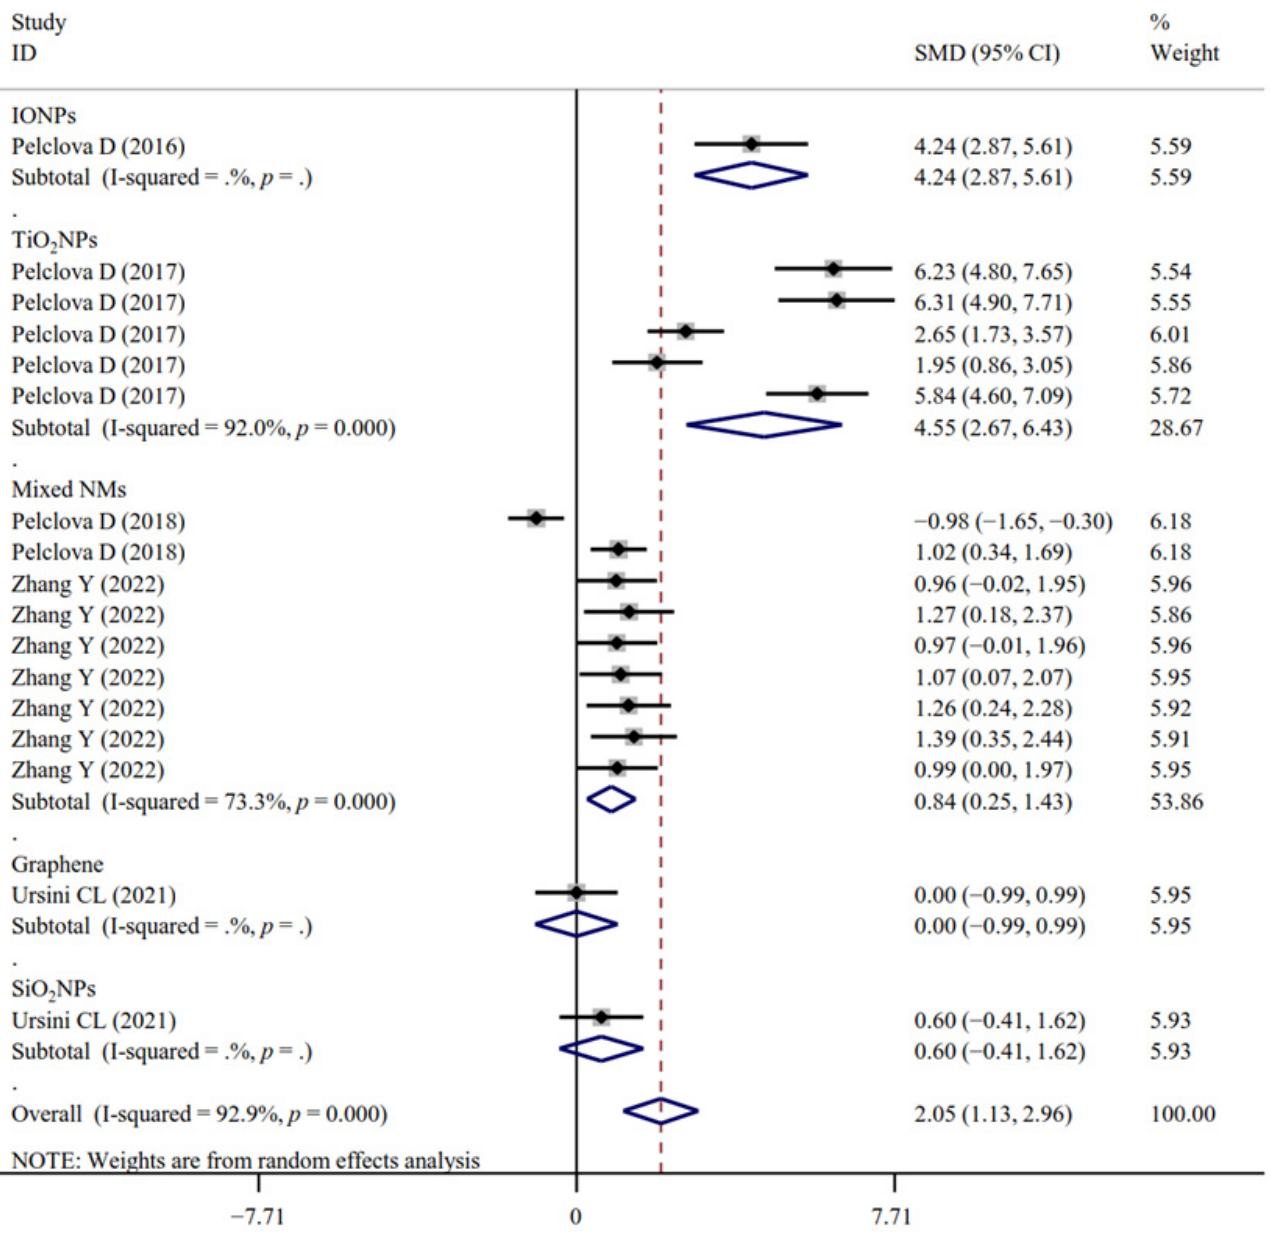
Figure 4. Forest plots assessing the effects of exposure to different NMs on the level of HNE compared with the non-exposed control group. NMs, nanomaterials; SiO 2 NPs, silica oxide nanoparticles; IONPs, iron oxide nanoparticles; TiO 2 NPs, titanium dioxide nanoparticles; HNE, 4-hydroxy-2-nonhenal; SMD, standardized mean difference; CI, confidence interval [15,18,29,31,33,34].